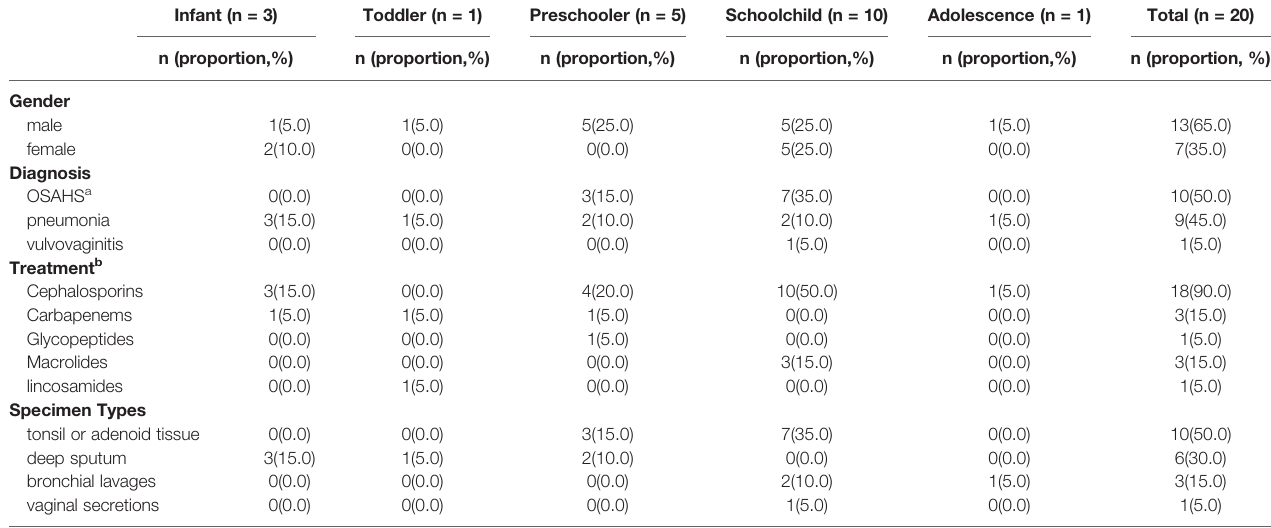
TABLE 1 | Clinical characteristics of children with mucoid serotype 3 Streptococcus pneumonia